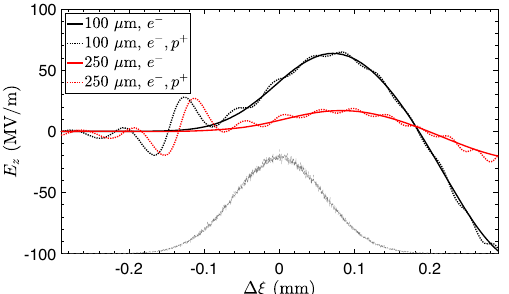
FIG. 8. Longitudinal wakefields at the exit plasma ramp region. Gray dashed line (arb. units) shows the longitudinal electron beam slice. The solid colored lines indicate the wakefields from the electron beam only, whereas the dotted lines represent cases with proton bunches. The initial electron beam sizes are 100 and 250 μ m.